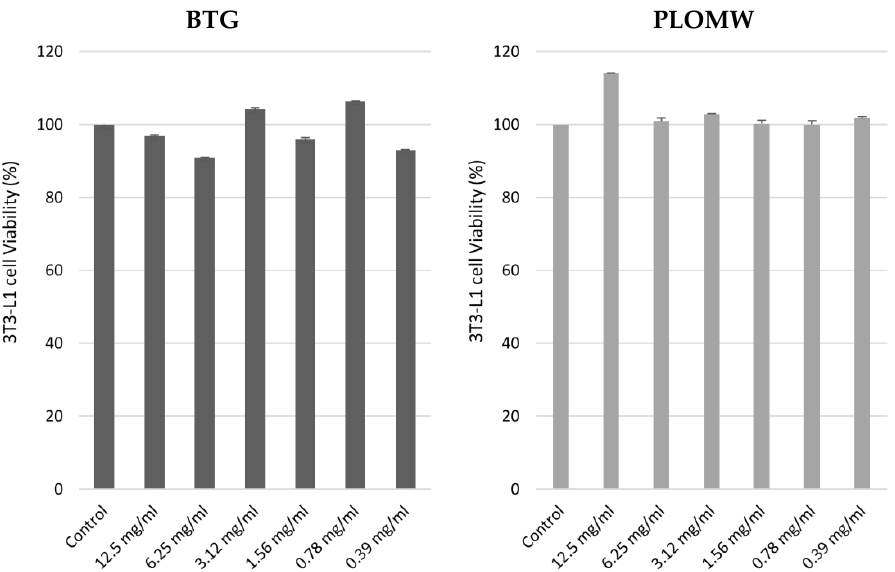
Figure 4. 3T3 cells viability (%) measured through NRU cytotoxicity assay upon treatment with increased concentrations of BGT and PLOMW (mg/mL). Each column represents the mean + SD of 3 wells/group.